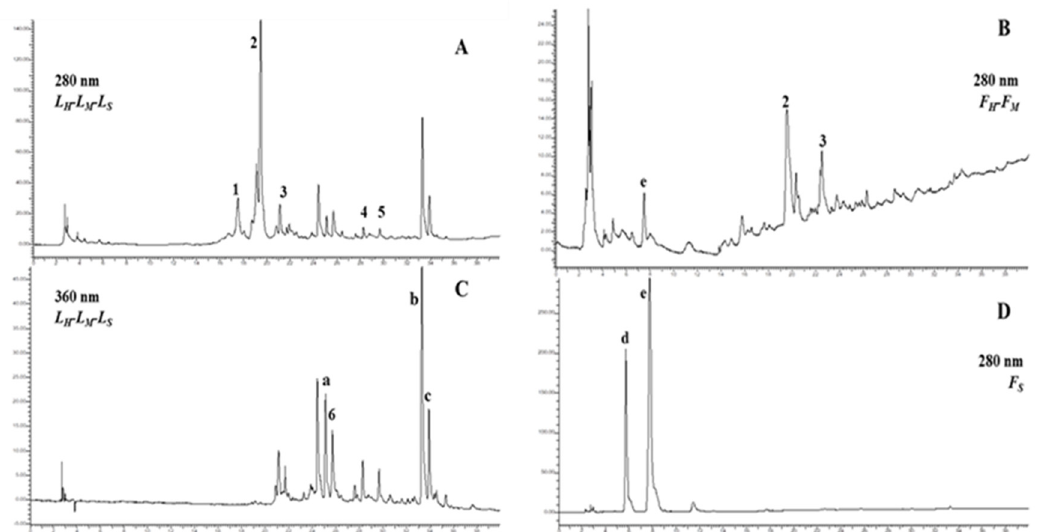
Figure 3. Chromatograms of phenolic compounds in leaf and fruit extracts by HPLC-DAD analysis at 280 ( A , B , D ) and 360 nm ( C ). Identified peaks: 1 . epicatechin, 2 . chlorogenic acid, 3 . caffeic acid, 4 . p -coumaric acid, 5 . ferulic acid, 6 . quercetin-3-D-galactoside; a . rutin, b . kaempferol glucoside derivative, and c . kaempferol were tentatively identified by literature